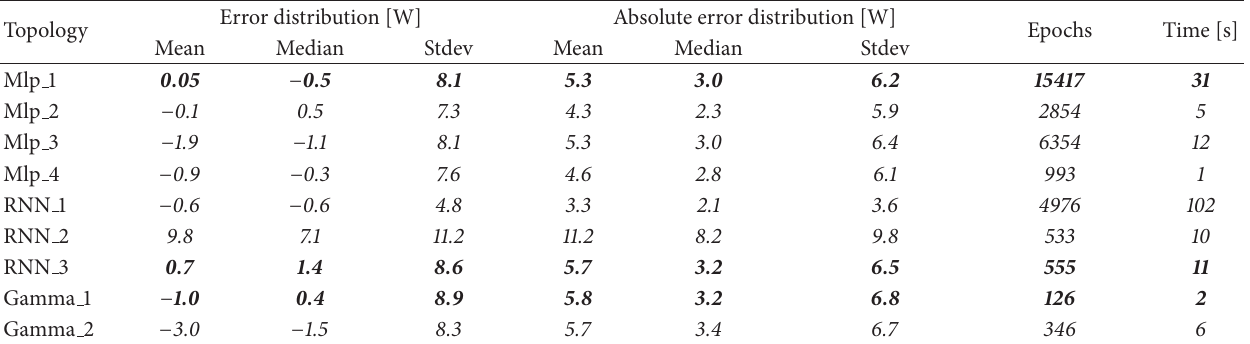
Table 5: ANNs results for the Kyocera panel; bold identifies the ANNs with the best performance. Error distribution [W] Topology